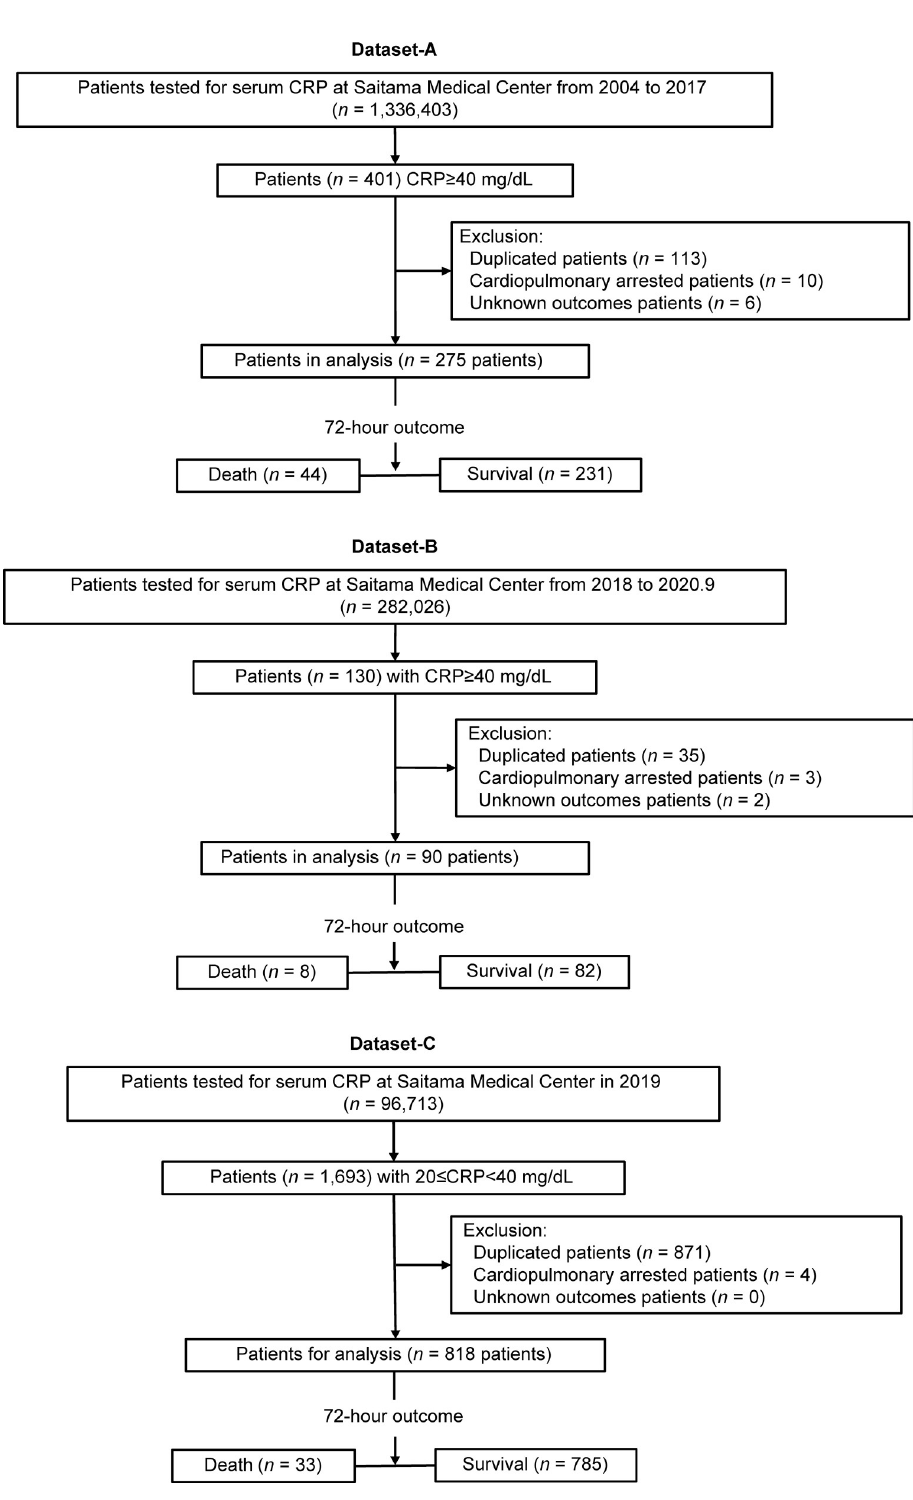
Fig 1. Flow diagram outlining the patient